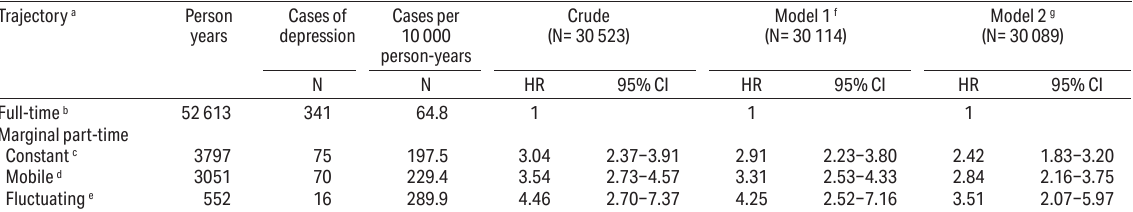
Table 2. The associations between retrospective trajectories of marginal part-time work and depression (N = 30 523). [HR=hazard ratio. CI=confidence interval].